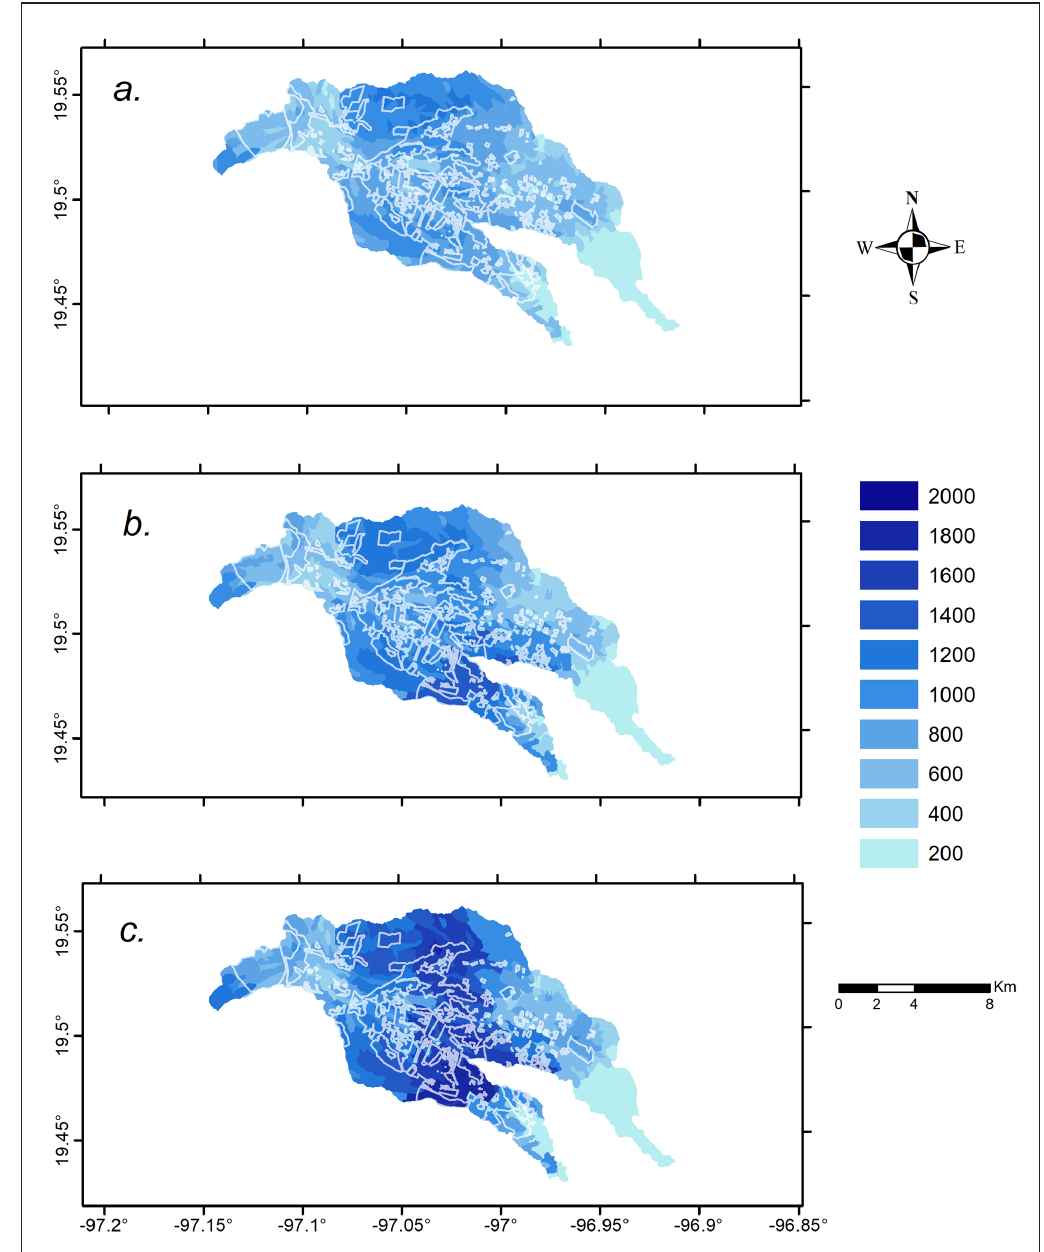
Figure 4: Annual average baseflow contribution distributions (in mm) obtained from the Soil Water Assessment Tool (SWAT) simulations with (a) the national climate stations alone, (b) volunteer rainfall data plus the national climate stations, and (c) the automatic gauge data plus the national climate stations. Gray overlay indicates the areas receiv- ing payment for hydrologic services (PHS) program